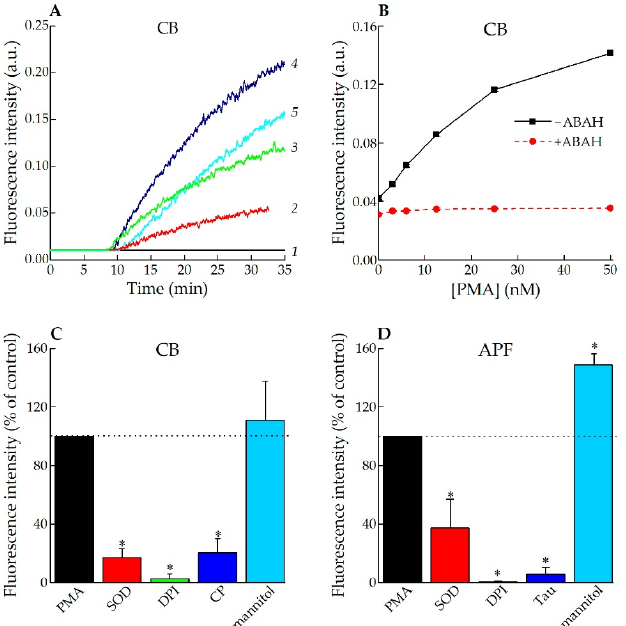
Figure 3. PMA-induced neutrophil activation. ( A ) Time-dependent changes in the fluorescence intensity of CB upon neutrophil activation. Neutrophils (10 6 cells/mL) were pre-incubated with different concentrations of CB: 5 μ M (2), 10 μ M (3), 20 μ M (4), 40 μ M (5) in the absence (1) and presence (2–5) of 50 nM PMA. (PBS + 20 mM Tau, pH 7.4, T = 37 °C; λ ex = 460 nm, λ em = 590 nm); ( B ) CB (20 μ M) fluorescence intensity after 60 min of neutrophils activation with PMA (0–50 nM) in the absence (solid line) and presence of an MPO inhibitor (50 μ M ABAH; dashed line). (PBS + 20 mM Tau, pH 7.4, T = 37 °C; λ ex = 460 nm, λ em = 590 nm); ( C ) CB (20 μ M) fluorescence intensity in PMA-activated neutrophil suspension in the absence and presence of ROS-generating scavengers and inhibitors. (PBS + 20 mM Tau, pH 7.4, T = 37°C; λ ex = 460 nm, λ em = 590 nm); * p < 0.05 versus the effect of PMA; ( D ) APF (2 µ M) fluorescence intensity in PMA-activated neutrophil suspension λ ex = 490 nm, λ em = 525 nm); * p < 0.05 versus the effect of